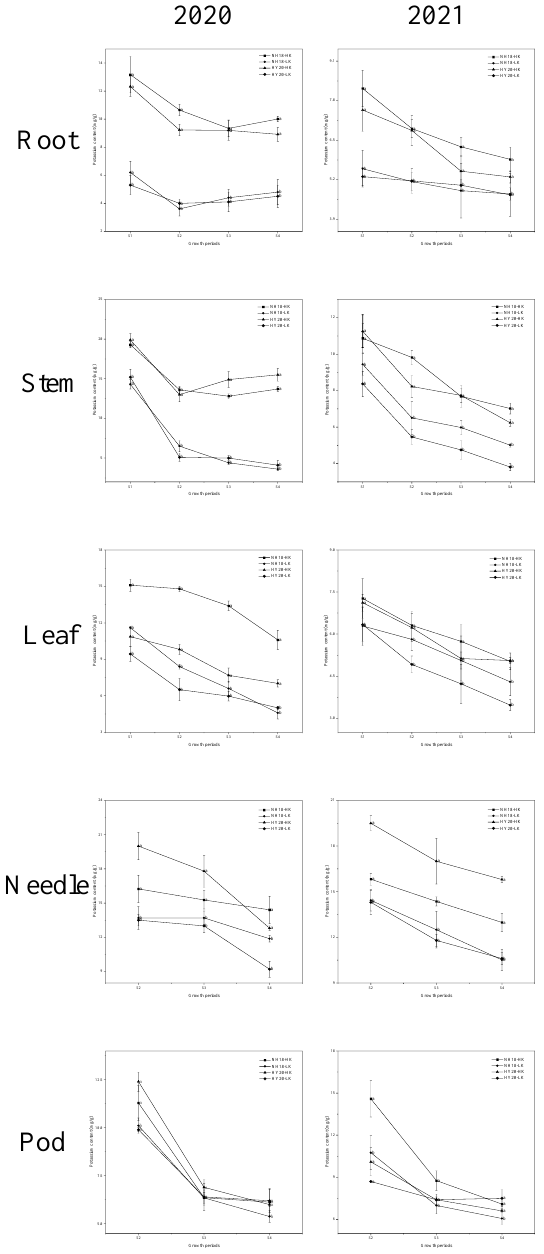
Figure 11. Changes in potassium (K) content in peanut organs under low K stress (mg/g). HK: high K treatment; LK: low K treatment. For the figure, a,b indicates a significant difference between different treatments for the same variety ( p < 0.05).